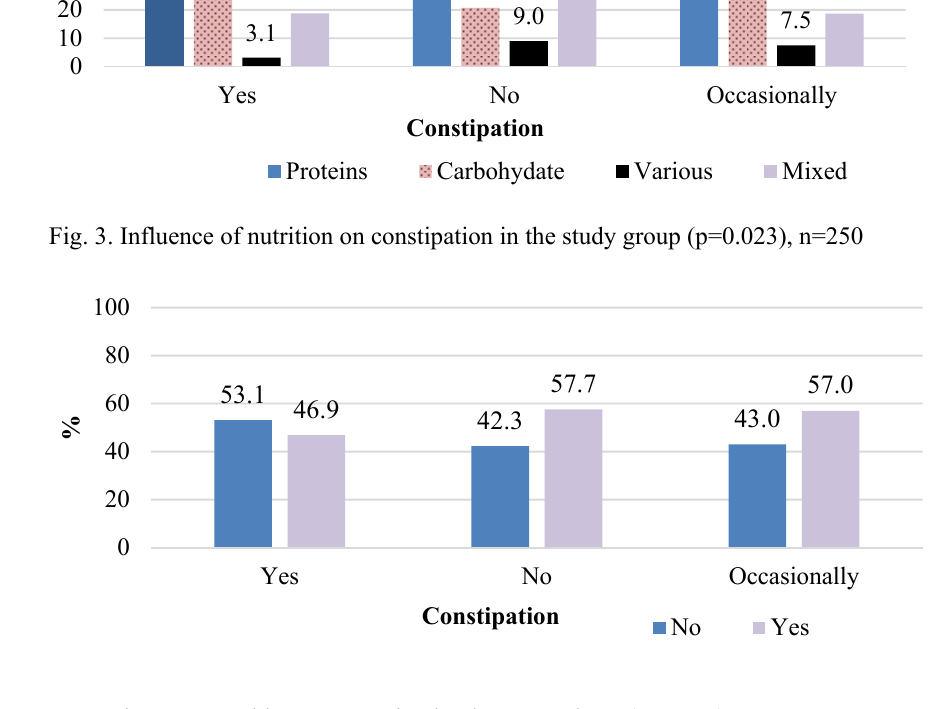
Fig. 4. Vegetables consumption by the respondents (p=0.535), n=250